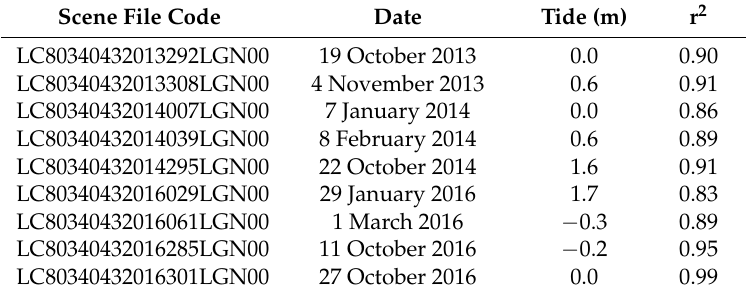
Table 1. Landsat 8OLI scenes codes processed in this study, with seatruth regression for 4SM retrieved depths. Scene File